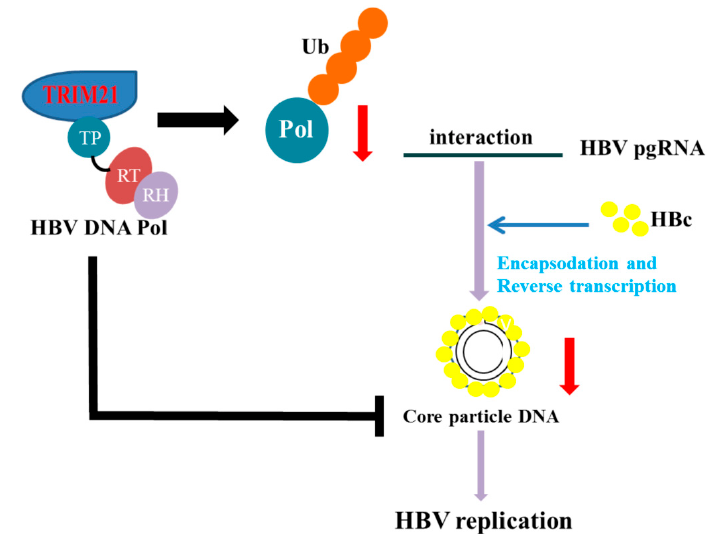
Figure 7. A proposed model describing the role of TRIM21 in the regulation of HBV DNA Pol and HBV DNA replication. HBV-encoded DNA Pol forms a complex with pgRNA and is packaged into a new viral particle by core protein. Some particles reenter into the nucleus and others are enveloped and released from cells for reinfection. Thus, HBV DNA Pol is necessary for HBV replication. Here, we show that TRIM21 mainly promotes the ubiquitination and degradation of HBV DNA Pol, which reduces HBV DNA replication.